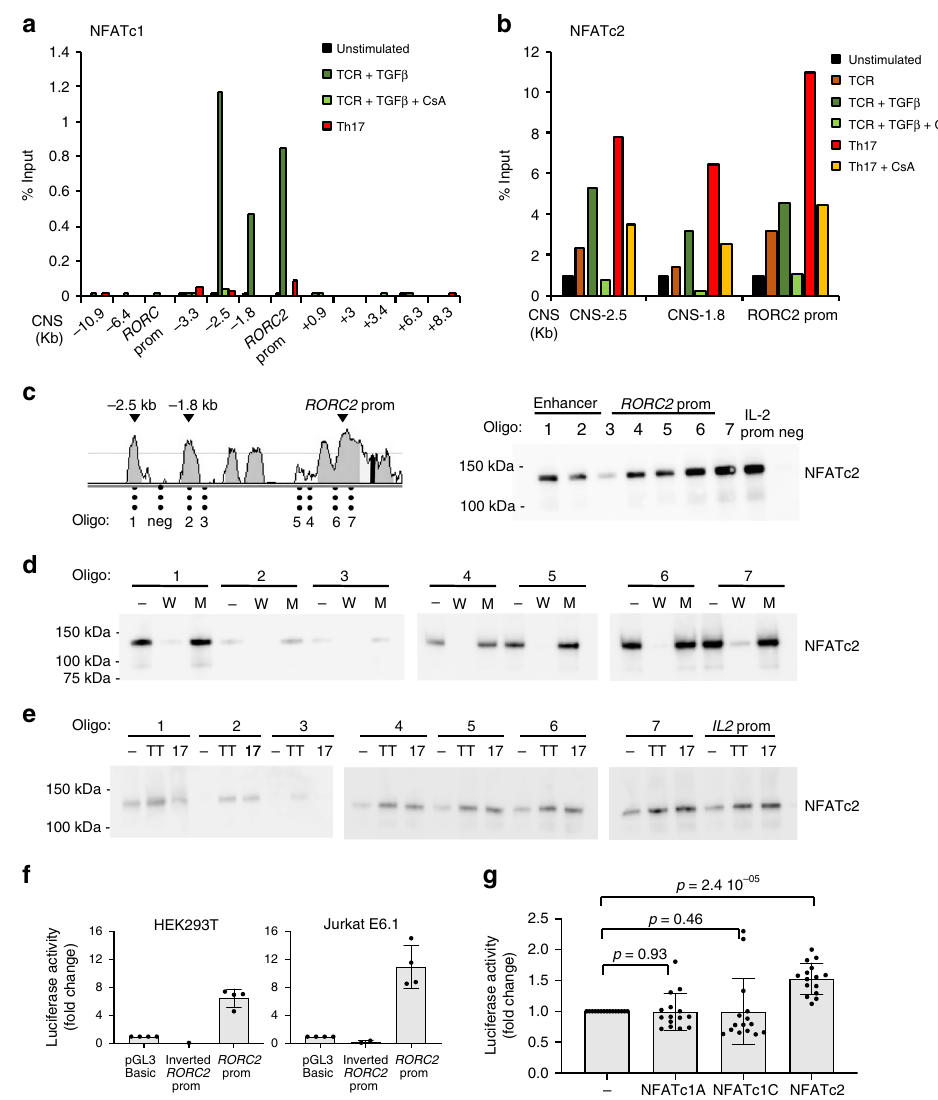
Fig. 5 NFAT binds to the RORC locus in stimulated CD4 + T cells. a NFATc1 binds to the RORC locus in stimulated CD4 + T cells. ChIP was performed on cord blood CD4 + T lymphocytes, followed by RT-qPCR of the indicated genomic regions. b NFATc2 binds to the RORC locus in Th17 cells. ChIP was performed as in a . Shown are one representative experiment of 3, average of three technical replicates. c Left: human/murine alignment of the RORC 2 promoter and upstream conserved region (CNS-2.5kb and -1.8 kb), with the position of the predicted NFAT binding sites tested in the DNA af fi nity capture assay. Right: DNA af fi nity capture assay on lysates from Jurkat E6.1 cells stimulated with PMA/ionomycin for 30 min. The western blot of